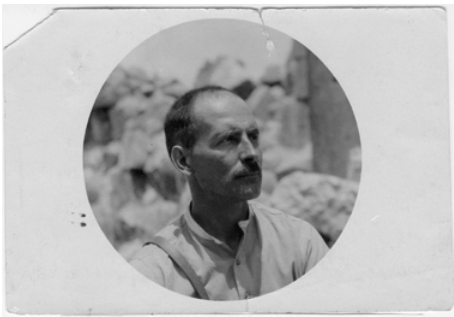
Fig. 3: Horsfield’s ‘Personality of the Week’ photograph, which was taken in Jerash in 1924. It was slightly adapted for publica- tion in the Illustrated London News . (Copy- right UCL Institute of Archaeology). [First published in Thornton